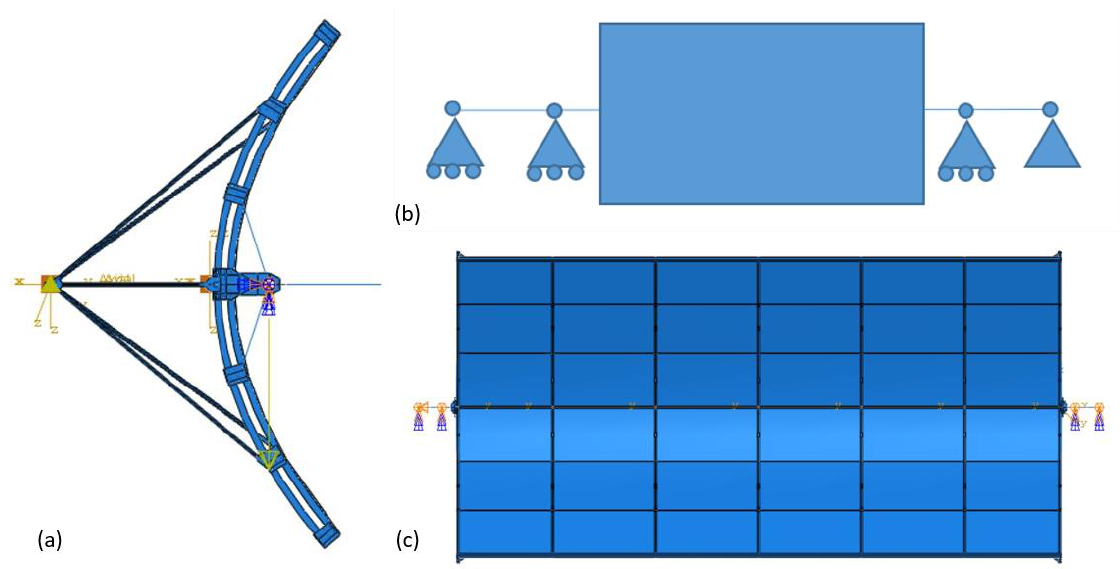
Figure 6. ( a ) Gravitational load, ( b ) bearing scheme, ( c ) bearing representation in the finite element (FE) model.